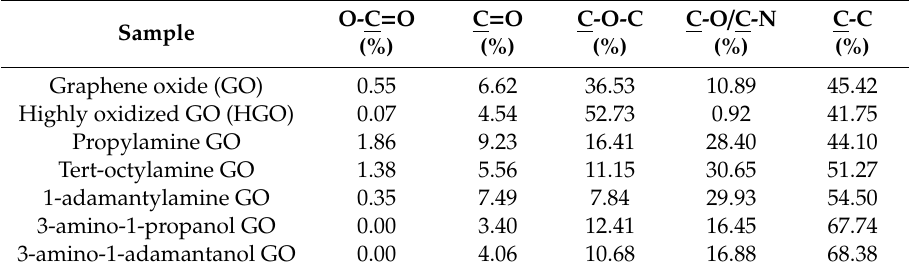
Figure 1. XPS spectra measurements (1S carbon (C1S) peak energies) of the GO materials; the C1S spectra is deconvoluted into five types, represented as C–C (blue), C–O (cyan), C–O–C (pink), C = O (green), and O–C = O (red) with the binding energies centered at 284.6, 285.6, 286.7, 288.2, and 289.4 eV, respectively. ( a ) GO and HGO ( b ) propylamine GO, tert-octylamine GO, and 1-adamantylamine GO ( c ) 3-amino-1-propanol GO and 3-amino-a-adamatanol GO. Relative atomic percentages were obtained by XPS survey spectra and included for each spectrum here. Table 1. XPS binding energies of the individual peaks of the carbon 1S